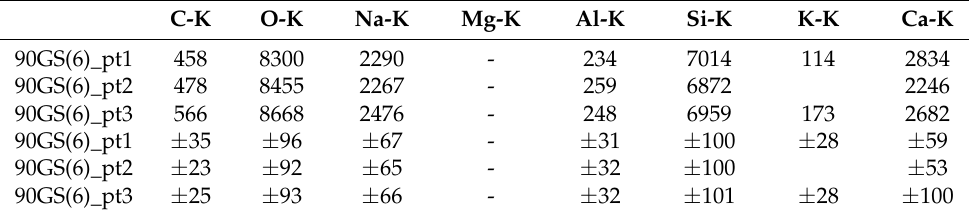
Figure 24. Microstructure of silicate bricks after 6 years (in 2022) from the laboratory production (in 2016); ( a ) microstructure of the laboratory bricks with 90% QS, 100 μ m magnification; ( b ) micro ‐ structure of the laboratory bricks with 90% GS, 100 μ m magnification.